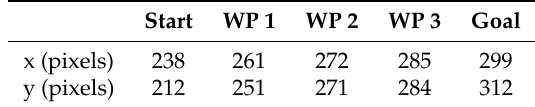
Table 1. Chosen optimal waypoints (WPs) from path